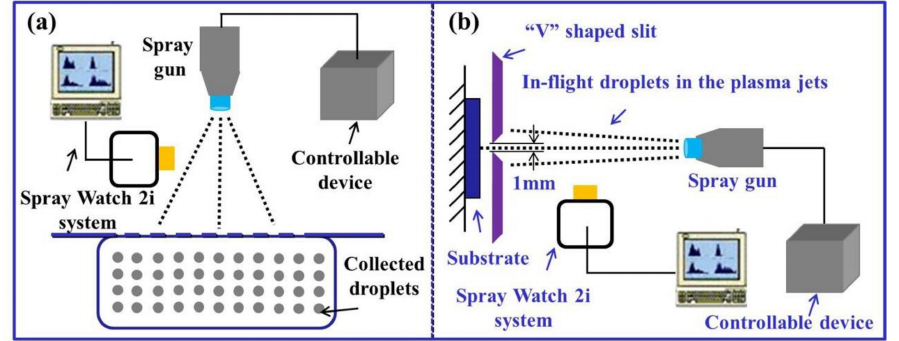
Figure 1. Collection schematic of in-flight droplets via both techniques: ( a ) experimental set-up of water collection; ( b ) a V-shaped shield of single flattened droplet.